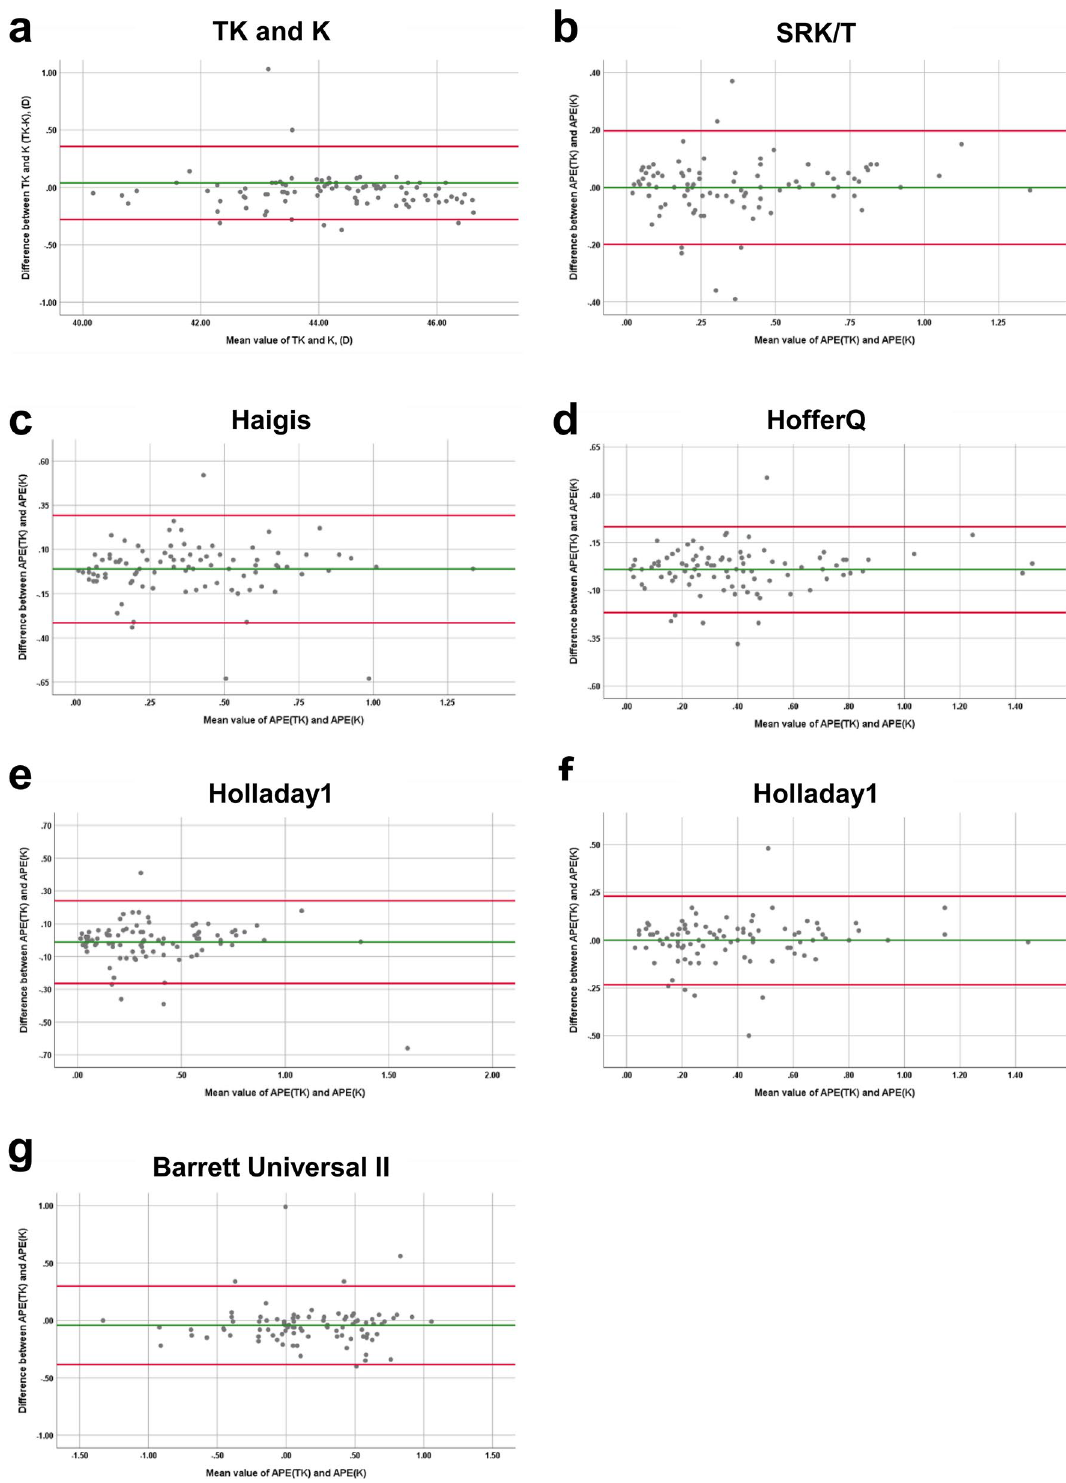
Figure 1. Agreement between conventional keratometry (K) and total keratometry (TK) for the normal range of keratometry values. A Bland–Altman plot between standard keratometry (K) and total keratometry (TK). ( b – g ) Agreement between absolute prediction error (APE) of spherical equivalent (SE) from standard keratometry (K) and total keratometry (TK) values. A Bland–Altman plot showing ( b ) APE of SE calculated using the SRK/T formula. ( c ) APE of SE calculated using the Haigis formula. ( d ) APE of SE calculated using the Hoffer-Q formula. ( e ) APE of SE calculated using the Holladay 1 formula. ( f ) APE of SE calculated using the Holladay 2 formula. ( g ) APE of SE calculated using the Barrett Universal II